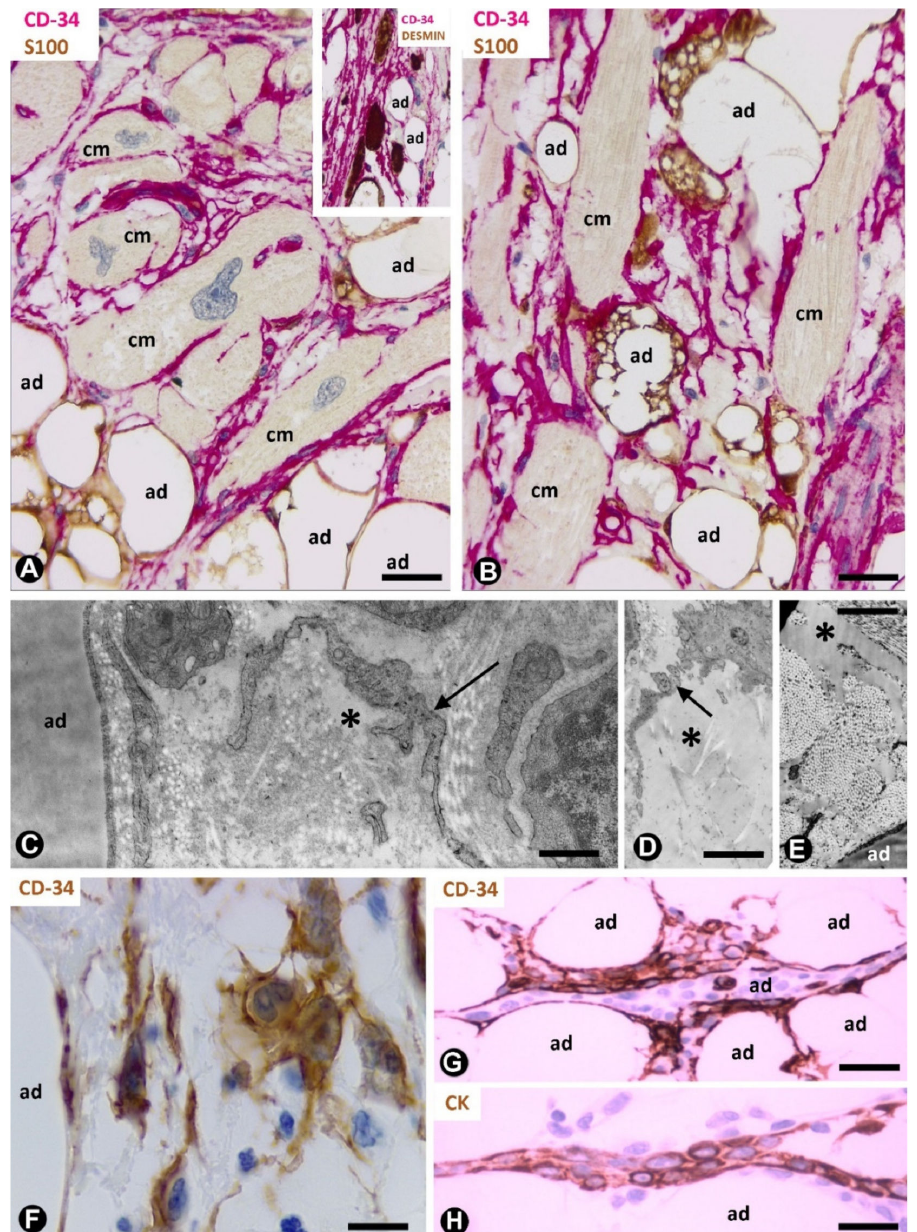
Figure 9. TCs / CD34 + SCs in the lipomatous hypertrophy of the interatrial septum, nevus cutaneous superficialis of Ho ff man–Zurhelle and irradiated adipose tissue. ( A , B ): lipomatous hypertrophy of the interatrial septum. Double immunochemistry labelling for CD34 (red) and S100 protein (brown). Numerous TCs / CD34 + SCs (red) are observed between cardiomyocytes (cm) and adipocytes (ad, brown). Note some multivacuolated cardiomyocytes. Insert of A: double immunochemistry labelling for CD34 (red) and desmin (brown). Desmin-positive cardiomyocytes (brown) are surrounded by TCs / CD34 + SCs (red); adipocytes: ad. ( C – E ): nevus lipomatosus cutaneous superficialis of Ho ff man–Zurhelle. Ultrastructural images of a TC (( D ), arrow) or TC processes (( C ), arrows) and free fat in the interstitium (( D , E ), asterisks); adipocytes = ad. ( F – H ): irradiated fat in rectal and perirectal tissues ( F ) and in the thymic region ( G , H ). Immunochemistry labelling for CD34 ( F , G ) and cytokeratin ( H ). Increased numbers of TCs / CD34 + SCs (brown) showing prominent processes. Observe some of these cells around inflammatory cells ( F ) and strips of thymic epithelium ( G ), which express cytokeratin (( H ), brown). Bar: ( A , B ): 40 µ m; ( C – E ): 4 µ m; ( F ): 20 µ m; ( G , H ): 40 µ